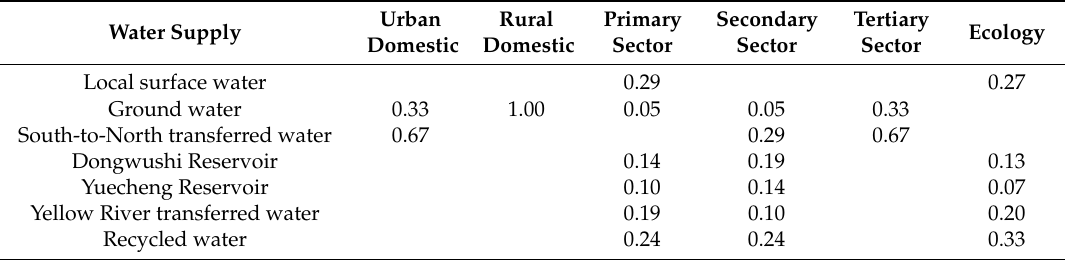
Table 3. Coefficients of water supply sequence for different water